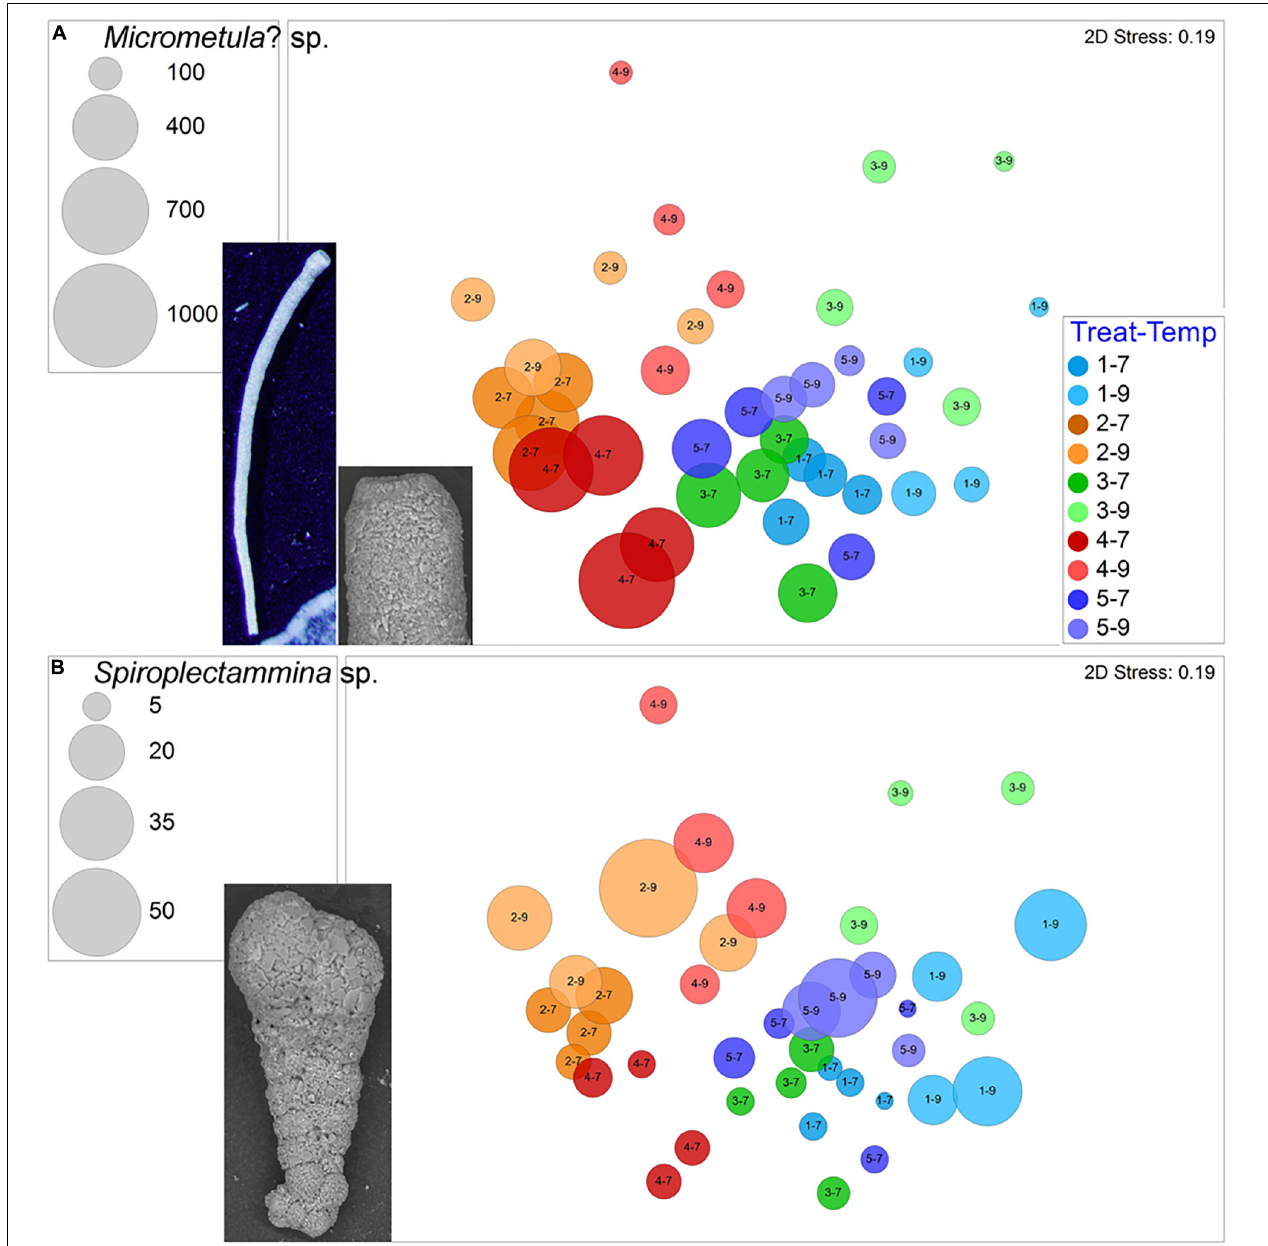
FIGURE 6 | Bubble plots projecting abundances in containers (7 ◦ C Total/9 ◦ C Live) by morphospecies on 2-D nMDS plots. Bubbles are color coded to treatment; lighter shade represents warmer assemblages. Circle diameter is keyed to abundance. (A) Micrometula? sp., inset includes reflected light micrograph of partial specimen and SEM image of apertural end; (B) Spiroplectammina sp., inset is SEM image. Treatment 1 (blue) is Present Day; Treatment 2 (orange) is Hypoxia; Treatment 3 (green) is OA; Treatment 4 (red) is OA + Hypoxia; Treatment 5 (purple) is